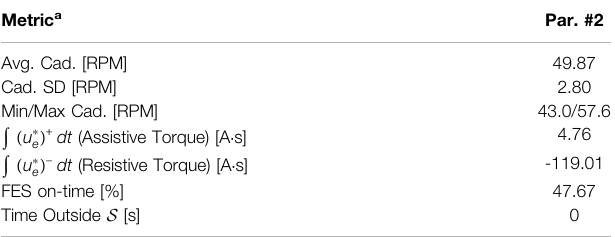
TABLE 2 | Protocol B – barrier function controller: Cycling metrics during steady- state operation (140 second trial). Metric a Par.